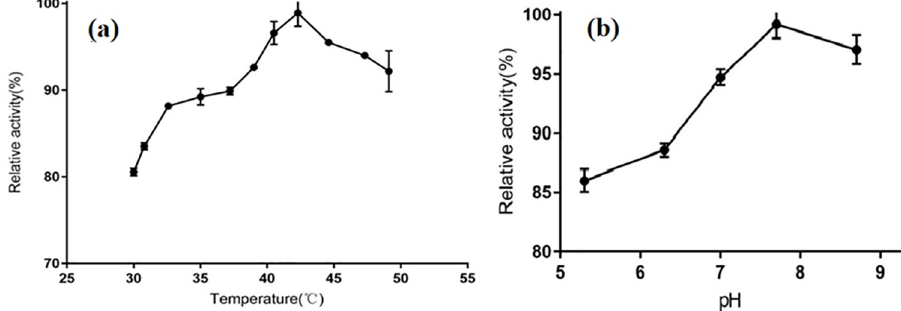
Fig 3. Effect of pH and temperature of the AKR. (A) Effect of temperature of the AKR; (B) Effect of pH of the